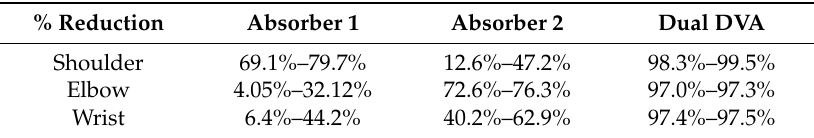
Table 5. Percentage of reduction in flexion motion at hand joints due to attaching “absorber 1”, “absorber 2” and “dual absorber” in the time domain.